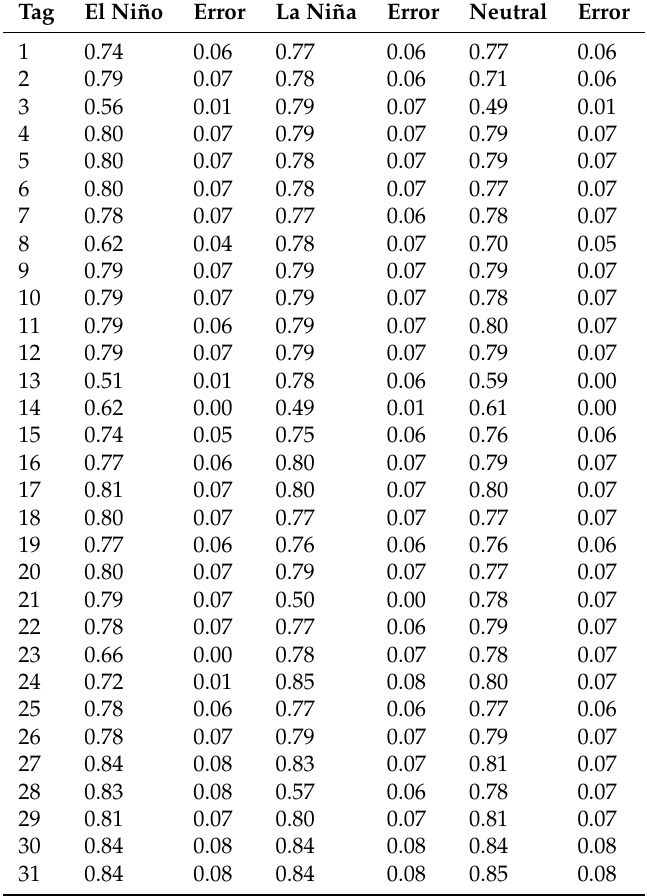
Table A1. The DFA coefficient ( α ) of solar radiation in less than twenty-seven hours. Tag El Niño